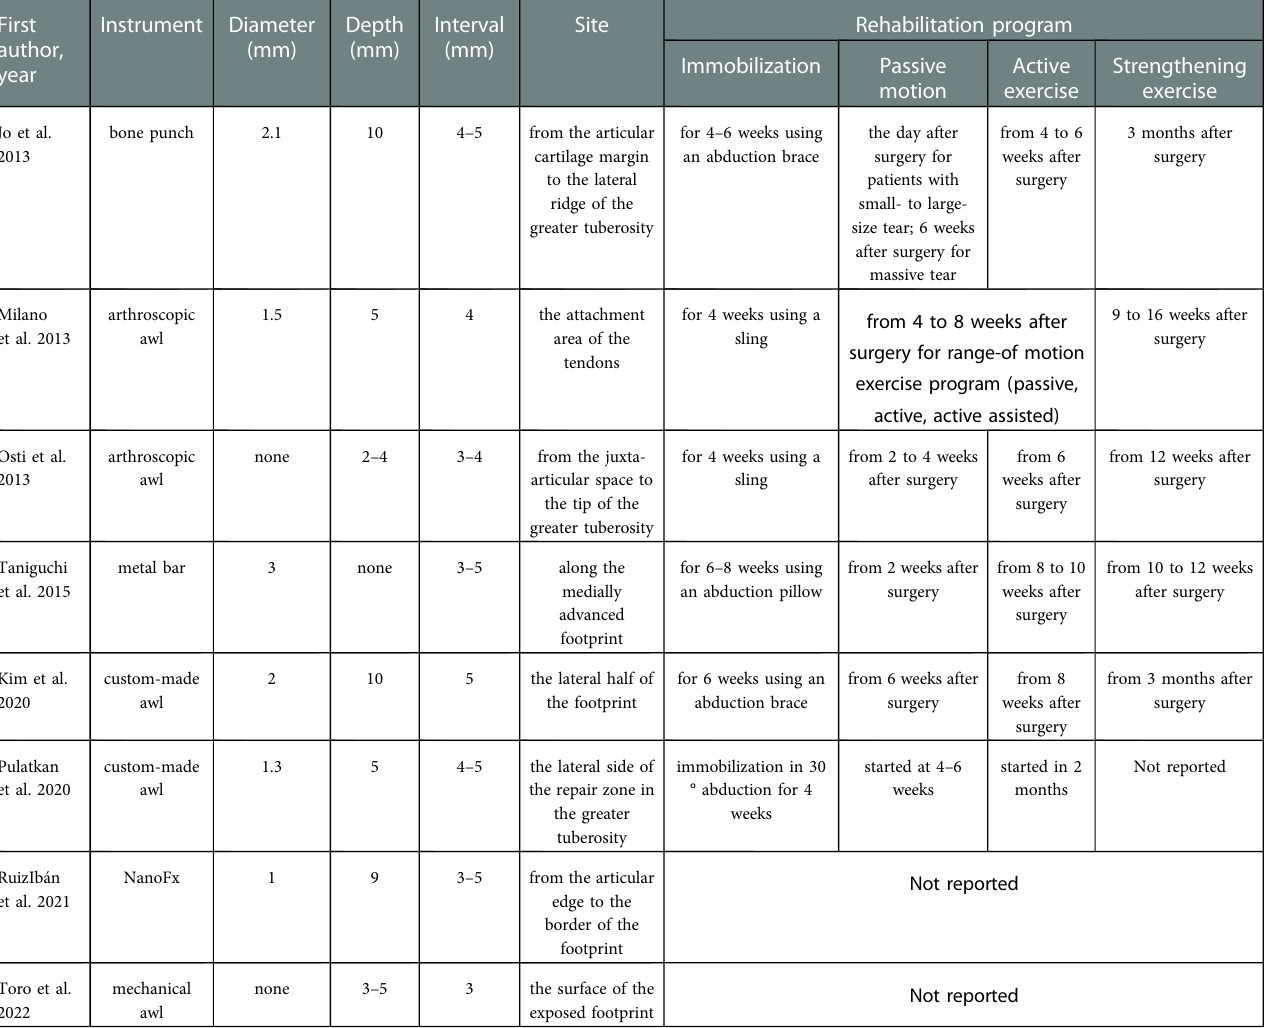
TABLE 2 Parameters of bone marrow stimulation technique and rehabilitation